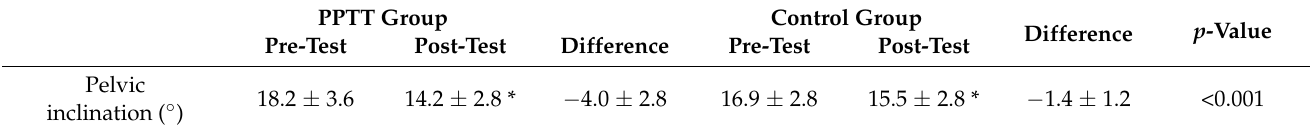
Table 2. Changes in pelvic inclination of the study participants (N = 40).